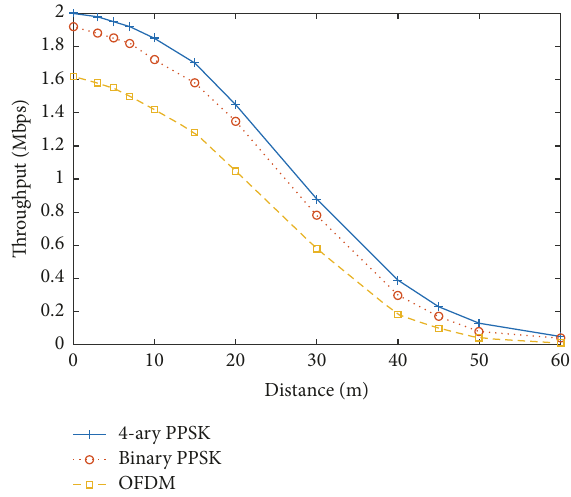
Figure 10: Comparative throughput performance of UWB-OFDM, Binary UWB-MPPSK, and 4-ary